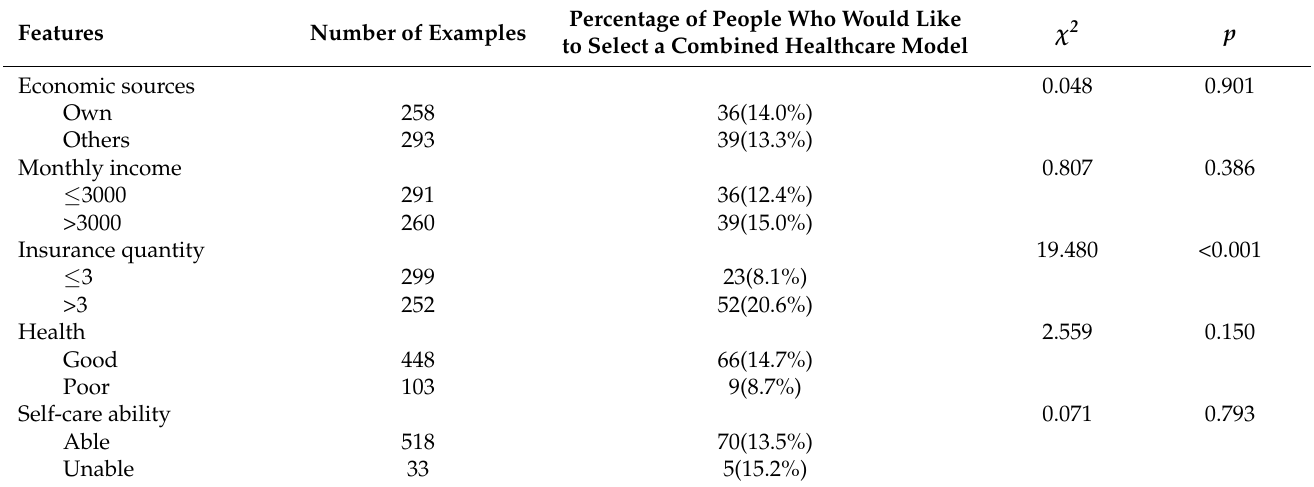
Table 2. Analysis of the willingness of the elderly to select the combined medical care and nursing care model with different